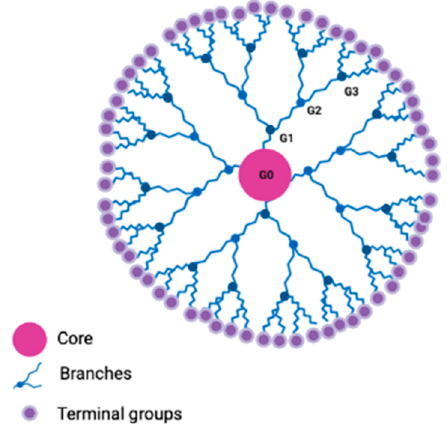
Figure 1. Dendrimer basic structure. DD architecture presents three well-differentiated parts: the central core (in pink), the branching units (in blue), and the terminal groups (in purple). Generation number (G) is indicated as G0, G1, G2 and G3.